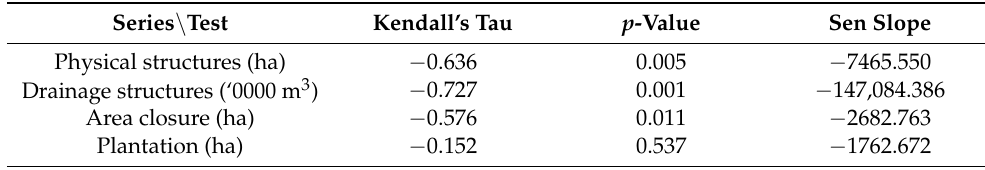
Table 5. Mann–Kendall trend and Sen Slope test summary results.